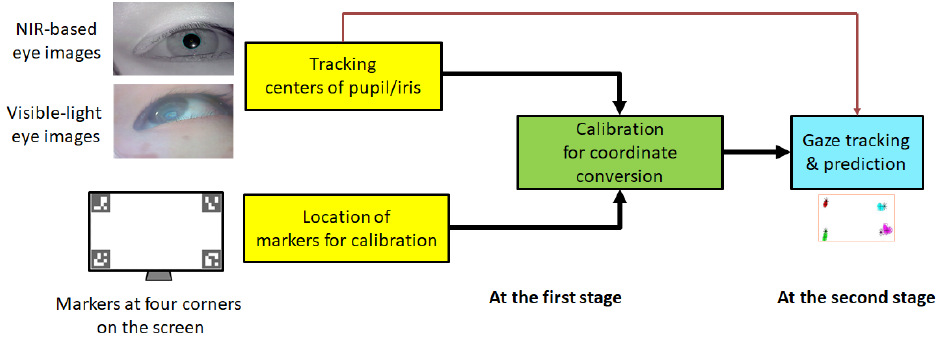
Figure 2. The general processing flow of the wearable gaze